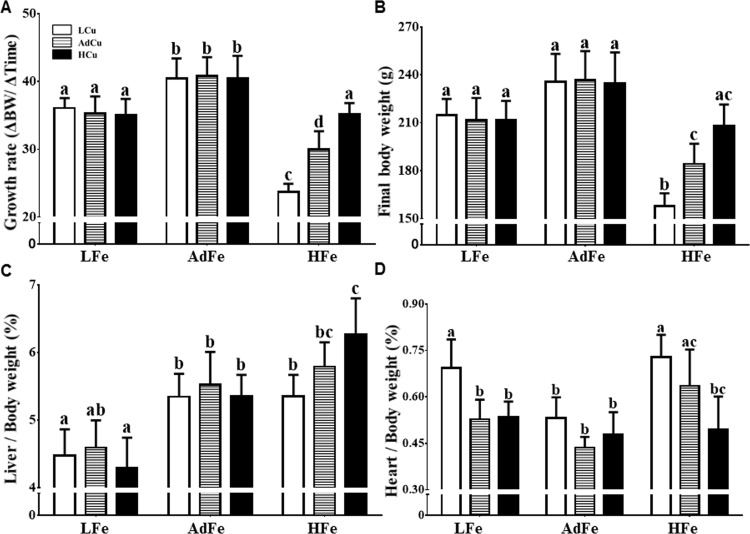
High-iron feeding impaired growth and caused cardiac hypertrophy.Weanling rats were fed one of 9 diets differing only in iron and copper content for 5 weeks ad libitum. Rats were weighed weekly, and growth rates were calculated (A). Final body weights (B), and liver (C) and heart (D) weights at sacrifice are also shown. Organ weights were normalized by body weight. Values are means ± SDs. Labeled means without a common letter differ (p<0.05). Animal numbers were as follows: LFe/LCu, n = 9; LFe/AdCu and LFe/HCu, n = 6; AdFe/AdCu, n = 11; and all others, n = 10. These same n values apply to all data presented in this manuscript (which will not be repeated in subsequent figure legends). Abbreviations: L, low; Ad, adequate; H, high. 2-way ANOVA factor analysis results are as follows: growth rate (Fe: p<0.0001; Cu: p<0.0001; Fe X Cu: p<0.001); final body weight (Fe: p<0.0001; Cu: p<0.01; Fe X Cu: p<0.001); liver weights (Fe: p<0.0001; Cu: ns; Fe X Cu: p<0.05); and heart weights (Fe: p<0.0001; Cu: p<0.0001; Fe X Cu: p<0.01). ns, not significant.